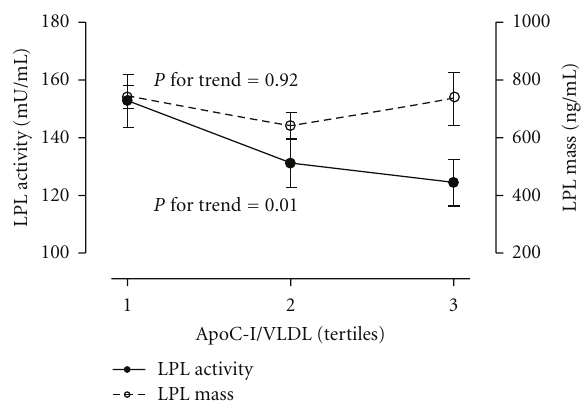
Figure 1: Line graph showing postheparin LPL activity and LPL mass across tertiles of the number of apoC-I per VLDL particle in the fasting state. Groups (T1–T3) were defined by their respective tertiles of the number of apoC-I per VLDL particle. Tertiles of the number of apoC-I per VLDL particle in the fasting state were as follows (mean, range): T1 (3.5, 0.5–5.0), T2 (6.2, 5.1–8.1), and T3 (12.8, 8.2–27.2). Values are means ± SEM.